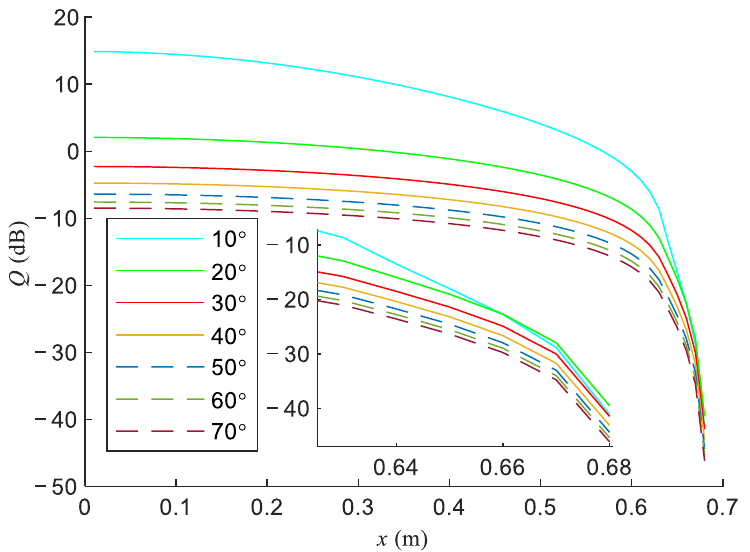
Figure 10. Calculation results of the relationship between the Q and x in the situation of a square empty room with an LED installed in the center of the